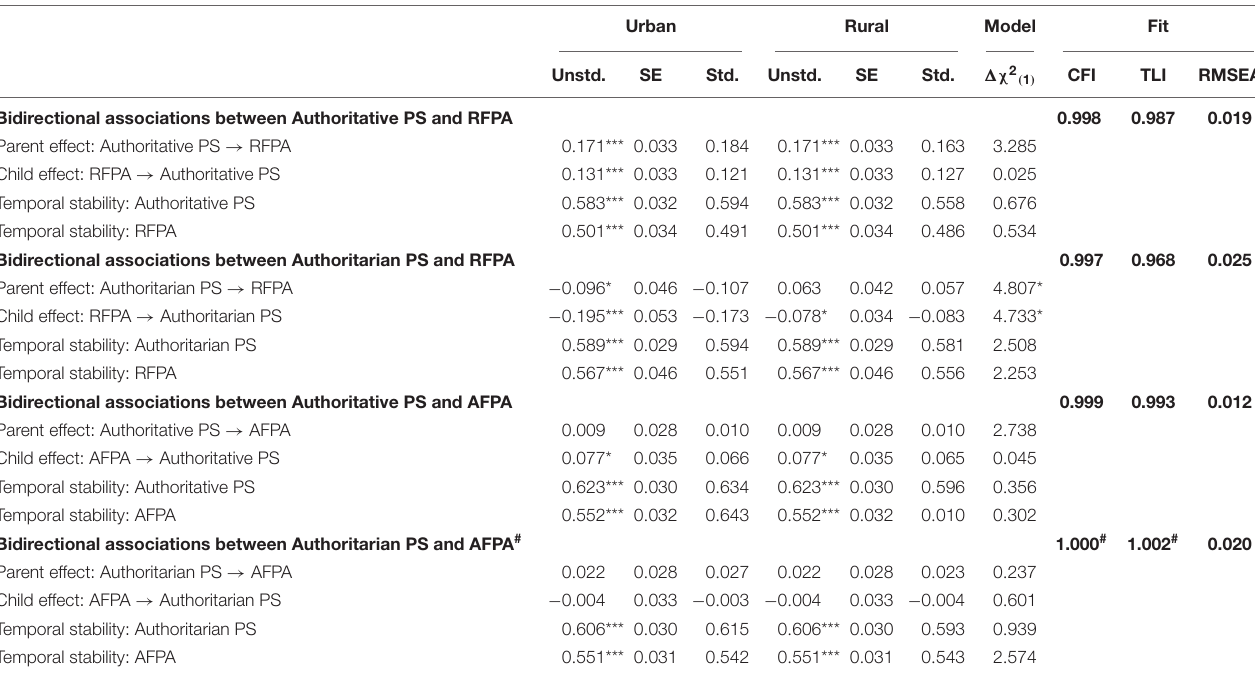
TABLE 4 | Estimates of the parent effects and the child effects in the path